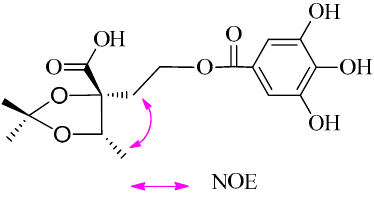
Figure 4. Key NOE correlations of 2,3- O -isopropylidene derivative of 2 .